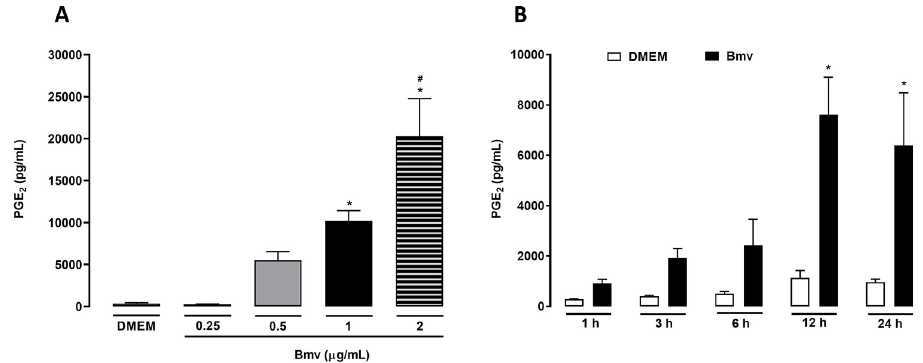
Fig 2. Bmv stimulates the release of PGE 2 by preadipocytes. ( A ) Release of PGE 2 induced by selected concentrations of Bmv. 3T3-L1 preadipocytes (2 x 10 5 cells/well) were incubated with Bmv at distinct concentrations (indicated above) or DMEM (control) for 24 h. Results are expressed as mean + S.E.M. (n = 4). � p < 0.05 vs respective control (DMEM); # p < 0.05 vs Bmv 1 μ g/mL group (unpaired t test). ( B ) Time course of Bmv-induced synthesis of PGE 2 . 3T3-L1 preadipocytes (2 x 10 5 cells/well) were incubated with Bmv (1 μ g/mL) or DMEM (control) for the indicated time intervals. Results are expressed as mean + S.E.M. of 3 independent assays (n = 4). � p < 0.05 vs negative control (DMEM) (ANOVA and Bonferroni post test). Concentration of PGE 2 in culture supernatants was evaluated by EIA in both experiments.